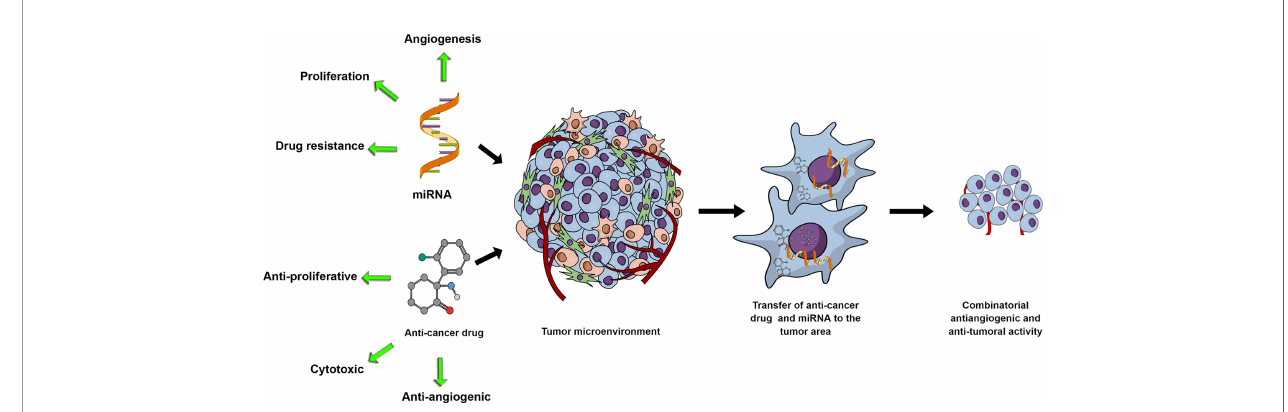
FIGURE 1 | miRNA and anti-cancer drug combinations can potentially synergistically affect tumor growth through their respective activities and potential synergistic effects on the tumor cells and the tumor microenvironment. With miRNAs mediating cell proliferation, drug resistance or angiogenesis, exogenous upregulation or inhibition of miRNAs in combination with anti-proliferative, cytotoxic or anti-angiogenic drugs represents a rationally designed and promising research